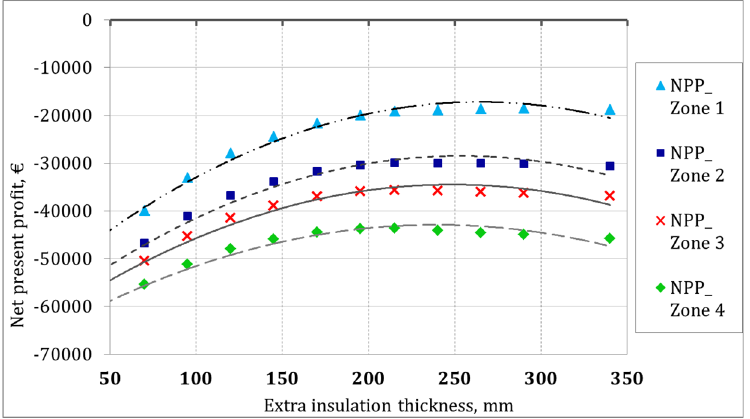
Figure 13. Net present profit of additional insulation on the exterior walls for the base case scenario.